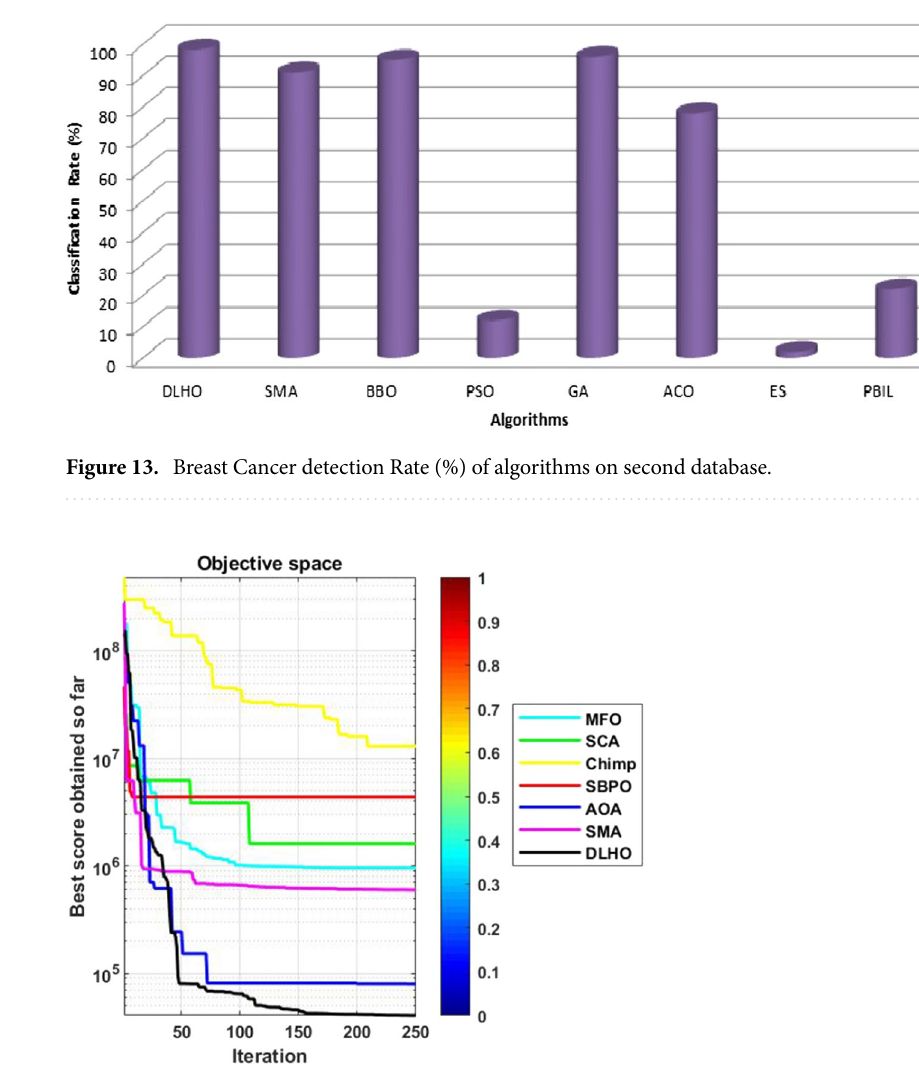
Figure 14. MSE graphs of algorithms on second database for cancer